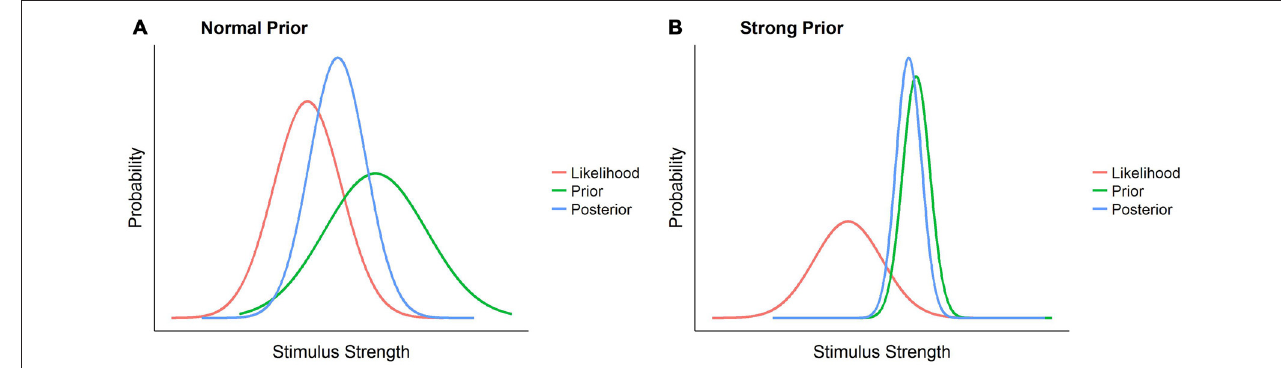
FIGURE 1 | A comparison between perception in presence of a strong prior and perception in presence of a normal prior. The normal prior scenario (A) represents how likelihood, prior and posterior, represented each as normal distributions, could look like in a normal scenario: a relatively reliable sensory signal, the likelihood, is combined with not particularly pronounced previous knowledge of the world, the prior, and form a posterior percept, with its mean between likelihood and prior and whose variance is lower than that of both. In the strong prior scenario (B) , on the contrary, the low variance of the prior attracts the posterior distribution such that the likelihood has an extremely limited influence on the posterior percept, which thus remains very close to the prior.